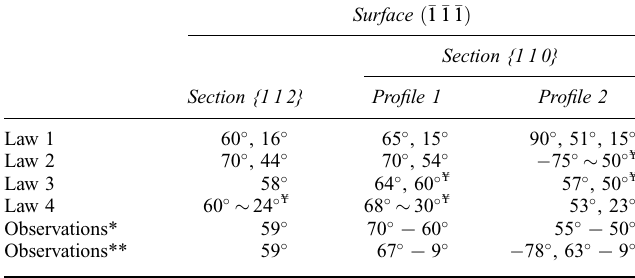
Note : (*) and (**) are for experimental values as reported by Iida and Ito for the H 2 SO 4 systems (*) and by Takebe et al. for HF mixtures (**), respectively. ¥ indicates the formation of a curved profile. The formation of two profile elements close together can be correlated to the development of a slightly curved